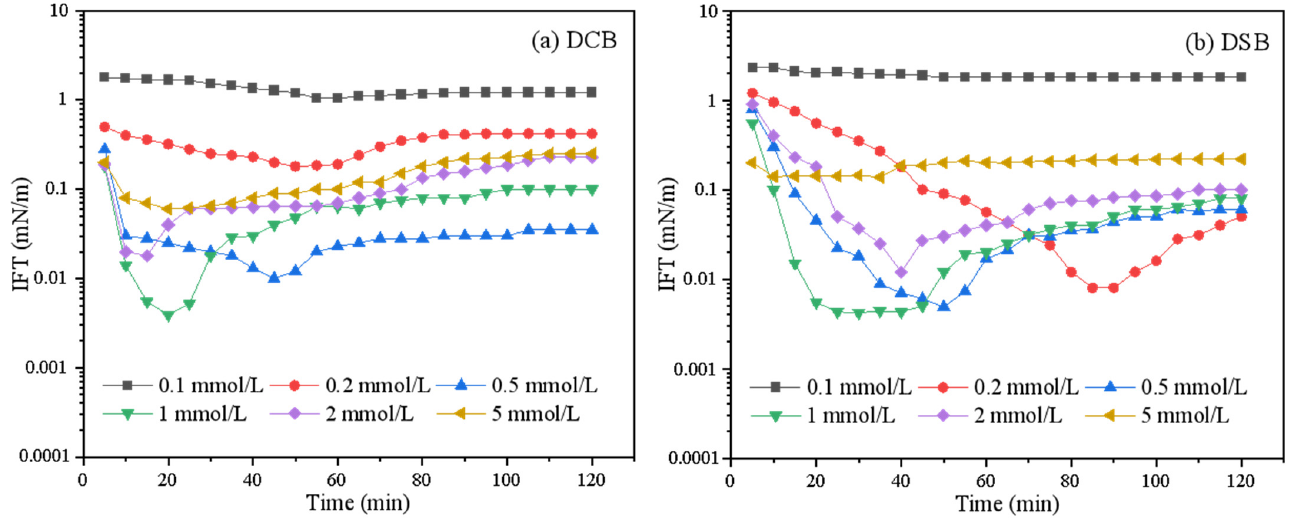
Figure 3. Variation of the interfacial tension with the surfactant concentration for DCB ( a ) and DSB ( b ) against Xinjiang crude oil at 40 °C.